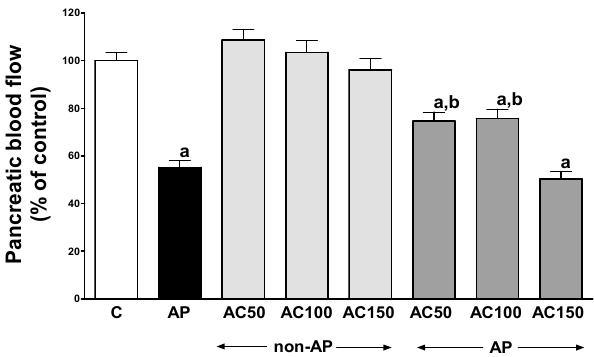
Figure 4. Impact of pretreatment with acenocoumarol on pancreatic blood flow in rats with or without cerulein-induced pancreatitis. Key: C = control; AP = cerulein-induced acute pancreatitis; non-AP = groups without induction of acute pancreatitis; AC = acenocoumarol; 50 = 50 µg/kg/day; 100 = 100 µg/kg/day; 150 = 150 µg/kg/day. Mean ± SEM. n = 10 in each group of rats. a p < 0.05 compared to control; b p < 0.05 compared to AP alone.